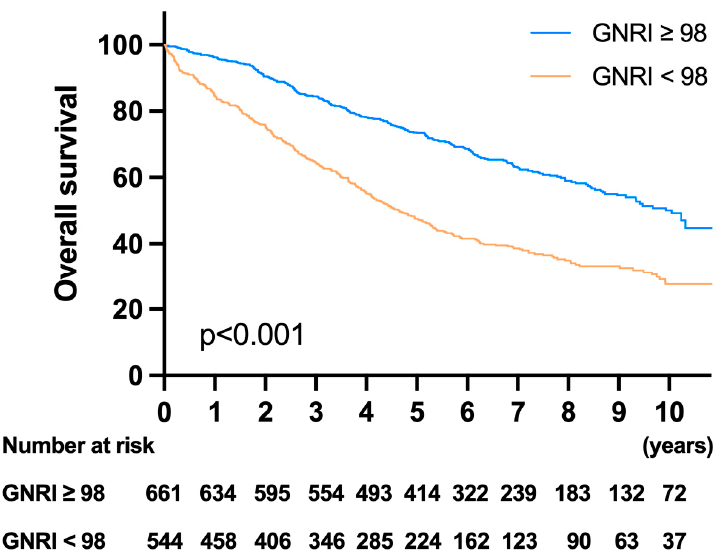
Figure 3. Kaplan–Meier survival analysis of OS according to the GNRI. Patients with a GNRI < 98 had significantly worse survival rates than those with a GNRI ≥ 98.